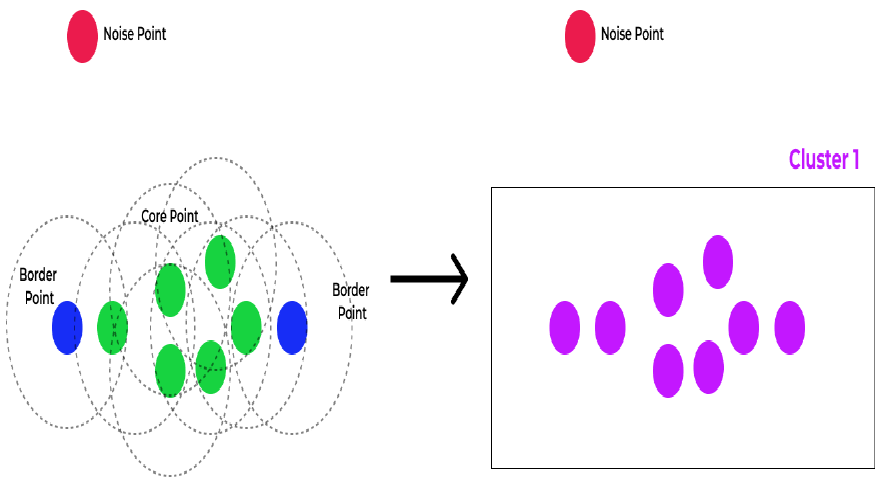
Figure 3. DBSCAN clustering results with MinPts =